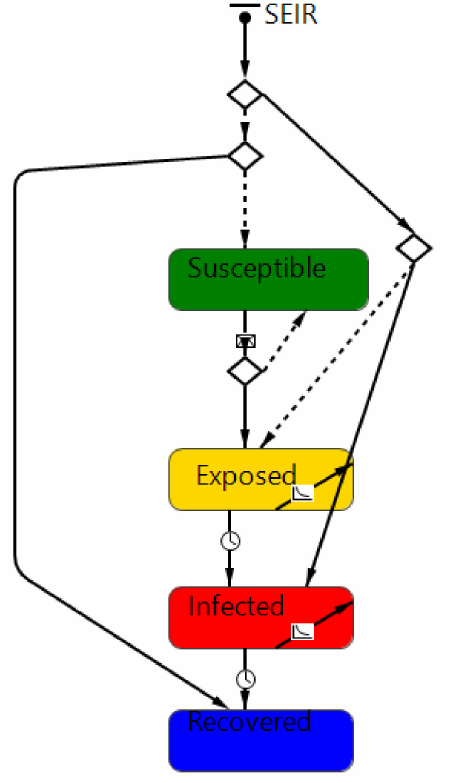
Figure 2. The general SEIR